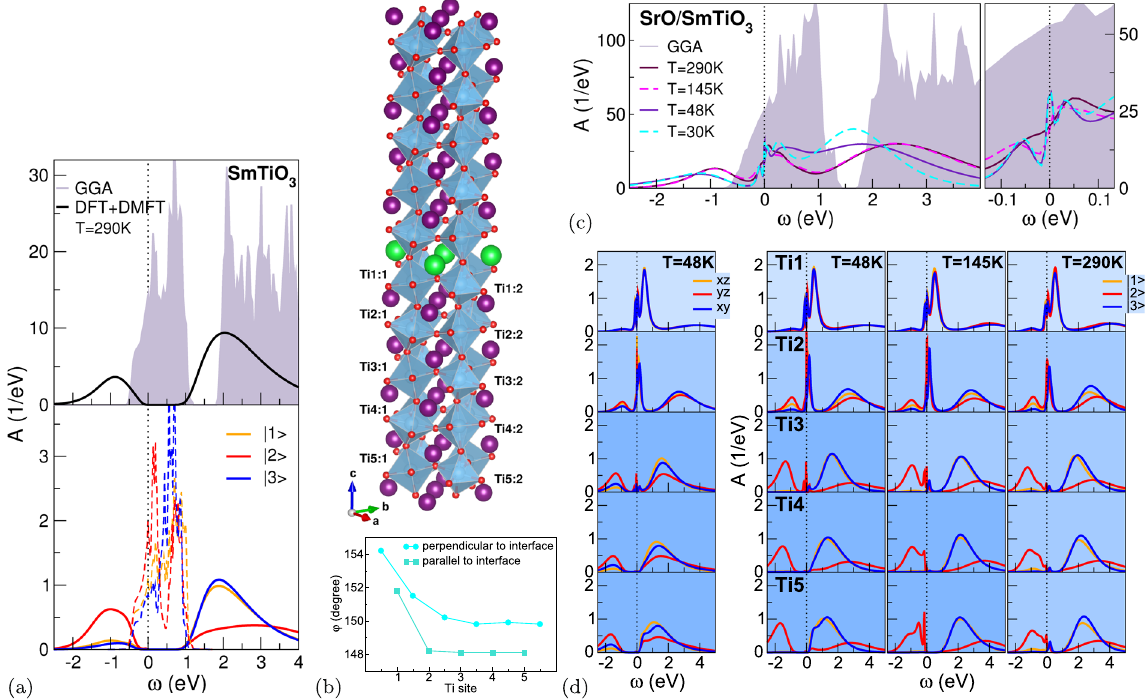
Figure 1. DFT + DMFT results for paramagnetic stoichiometric/ δ -doped SmTiO 3 . ( a ) Correlated electronic structure of bulk SmTiO 3 . Total (top) and local (bottom) spectral function, with dashed lines for the GGA data. ( b ) Top: supercell of the δ -doped compound: Sm (violet), Sr (green), Ti (lightblue), O (small red), bottom: Ti- O-Ti bond angles. ( c,d ) Spectral function of the δ -doped system, ( c ) total and ( d ) Ti-resolved. ( d ) Left: for a single temperature in the conventional cubic-harmonic t basis. Right: over a wider temperature range in the g 2 symmetry-adapted Ti-site dependent effective t g 2